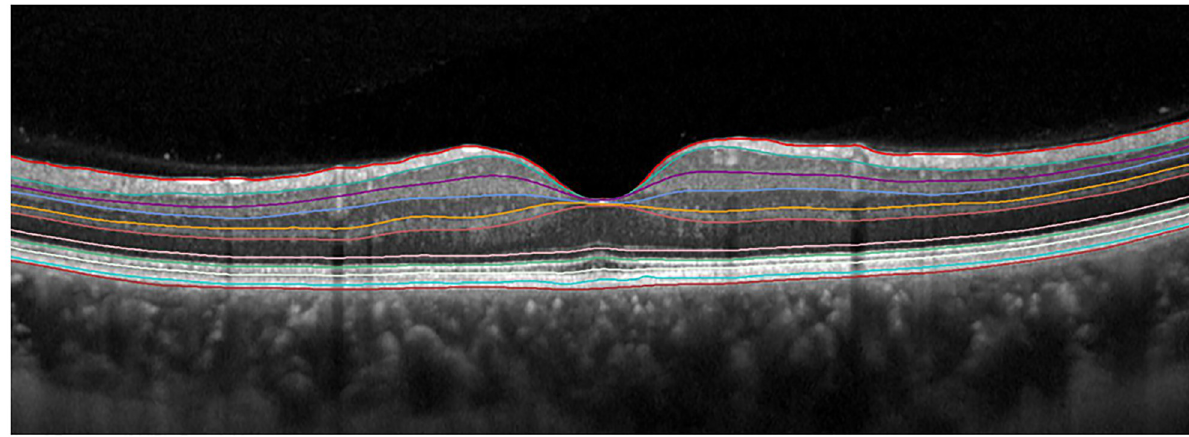
Fig 2. Representative automatic retinal layers